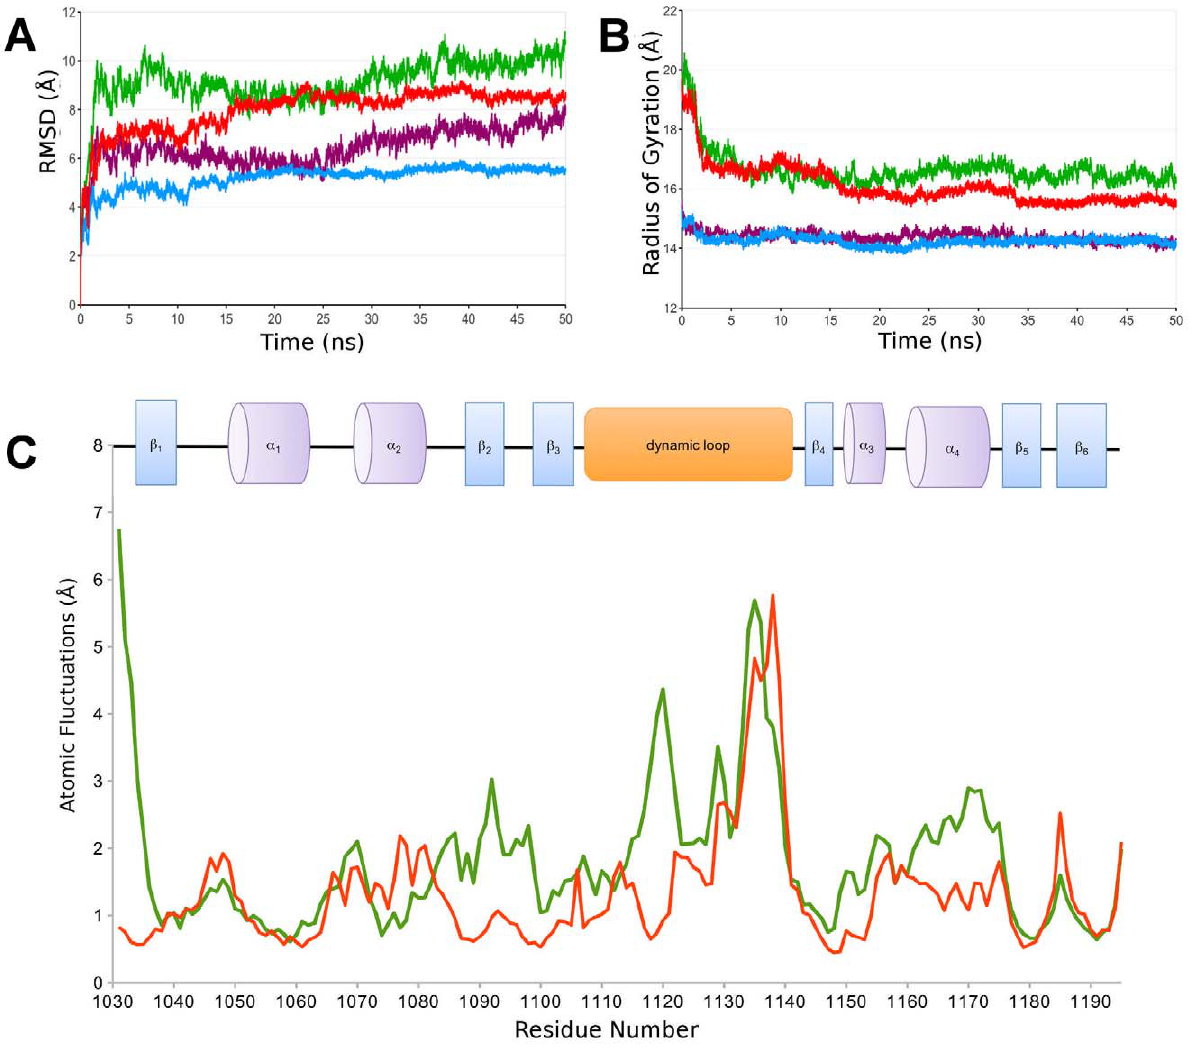
Figure 3. Analysis of the N-domain plasticity along MD simulations for WT and WT-Mg-ATP systems. (A) Root Mean Square Deviation (RMSD) of the C a atoms with the initial minimized structure used as reference for the 50 ns of MD simulations: whole Wild-Type protein of the N- domain (WT, green) and Mg 2 + -ATP complexed to the N-domain (WT-Mg-ATP, red). Purple and blue colors represent the RMSD of the C a atoms calculated without taking into account the dynamic loop (A1114-T1143) for WT and WT-Mg-ATP system, respectively. All structures were previously fitted to the initial structure of the MD simulation considering the WT for all trajectories. (B) Radius of gyration of C a atoms for WT and WT-Mg-ATP systems. Color scheme is the same as previously defined. (C) Atomic fluctuations of C a atoms for WT (green) and WT-Mg-ATP systems